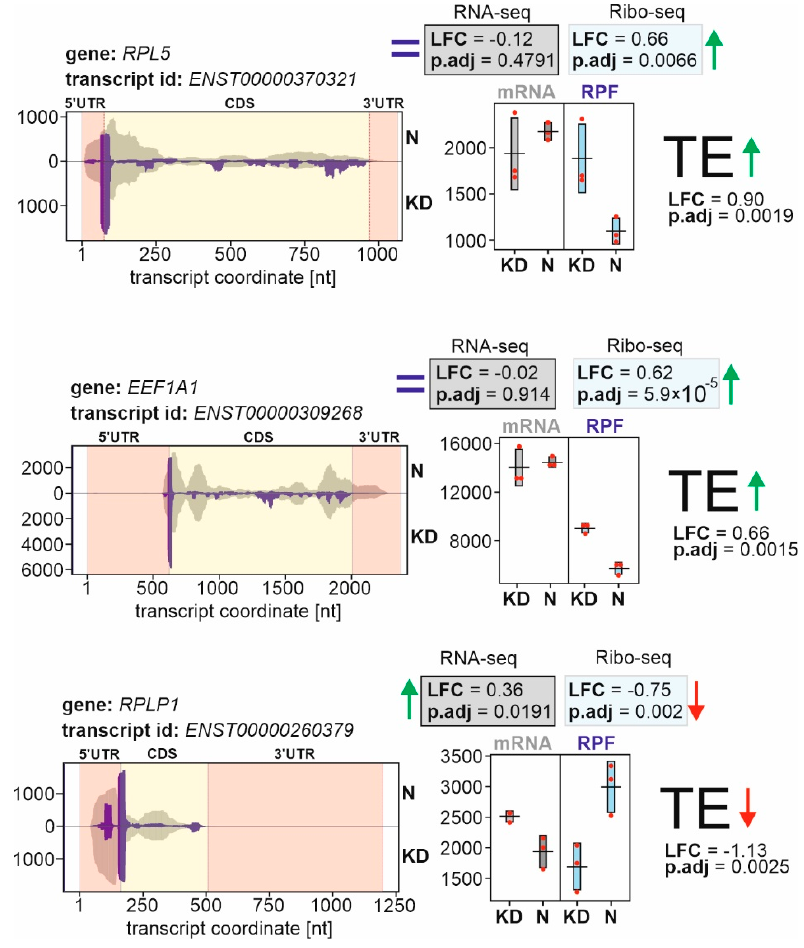
Figure 2. The coverage plots for three representative genes with differential translational efficiencies (GDTEs) in HEK293 cells treated with specific siRNAs against eL38 mRNA and with non-targeting siRNA. The left panels show the normalized read coverage of gene regions, given in coordinates of the respective transcripts, for cells with normal eL38 level (the upper part, N) and eL38 knocked down cells (the lower part, KD). The brown and purple histograms on the plots illustrate the read densities across these regions derived from the RNA-seq and Ribo-seq data, respectively. The yellow and peach areas on the plots correspond to the coding sequences (CDSs) of transcripts and their 5 (cid:48) - and 3 (cid:48) -untranslated regions (UTRs), respectively. The right panels present the dot plots of normalized read counts obtained from the RNA-seq (“mRNA” plot) and Ribo-seq (“RPF” plot) data in three replicates. The DESeq2-derived statistics, Log2FoldChange (LFC) and p adjusted ( p .adj) values, are given inside the boxes. The TE change for each gene is designated by an arrow and its statistics are